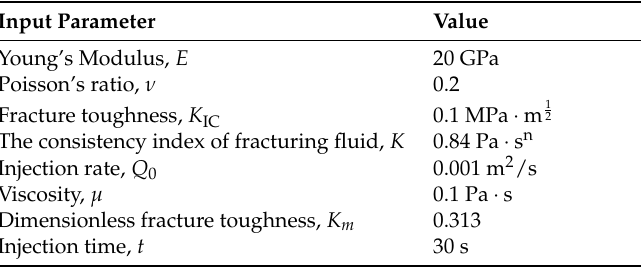
Table A1. Input parameter values of hydro-fracturing.